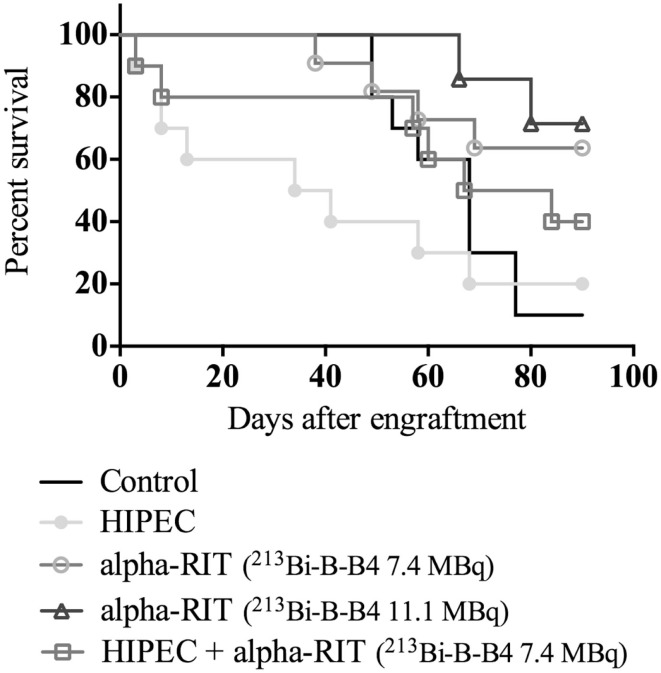
Survival rates according to treatment groups. This figure shows the Kaplan–Meier survival curves of mice as a function of treatment by day 3, and according to the number of days.